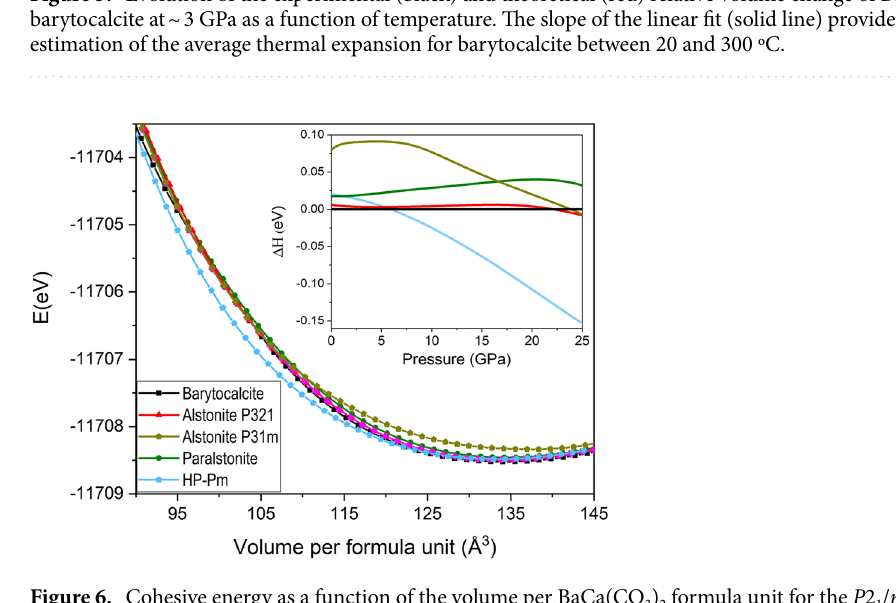
Figure 6. Cohesive energy as a function of the volume per BaCa(CO 3 ) 2 formula unit for the P 2 1 / m barytocalcite and HP Pm post-barytocalcite phases, but also P 321 alstonite 13 , P 31 m alstonite 12 and P 321 paralstonite 11 phases. Inset: Enthalpy difference as a function of pressure, showing the stabilities with respect to P 2 1 / m BaCa(CO 3 ) 2